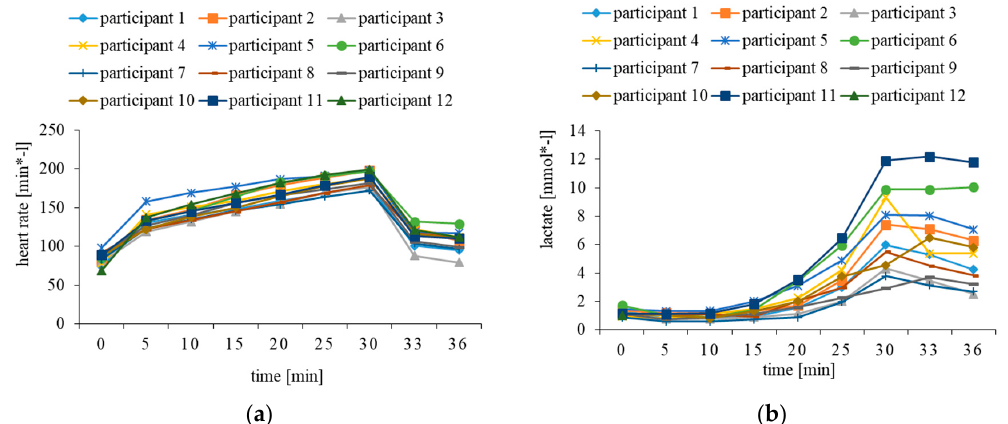
Figure 1. Heart rate ( a ) and lactate concentrations ( b ) before, during and 3 to 6 min after the graded exercise test.